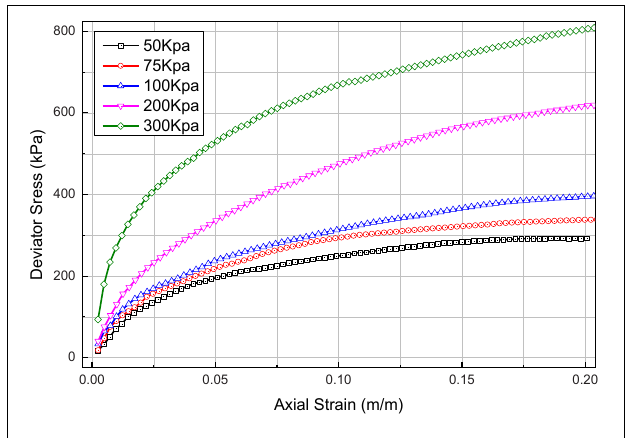
FIGURE 5 | Stress-strain curve of red-clay.